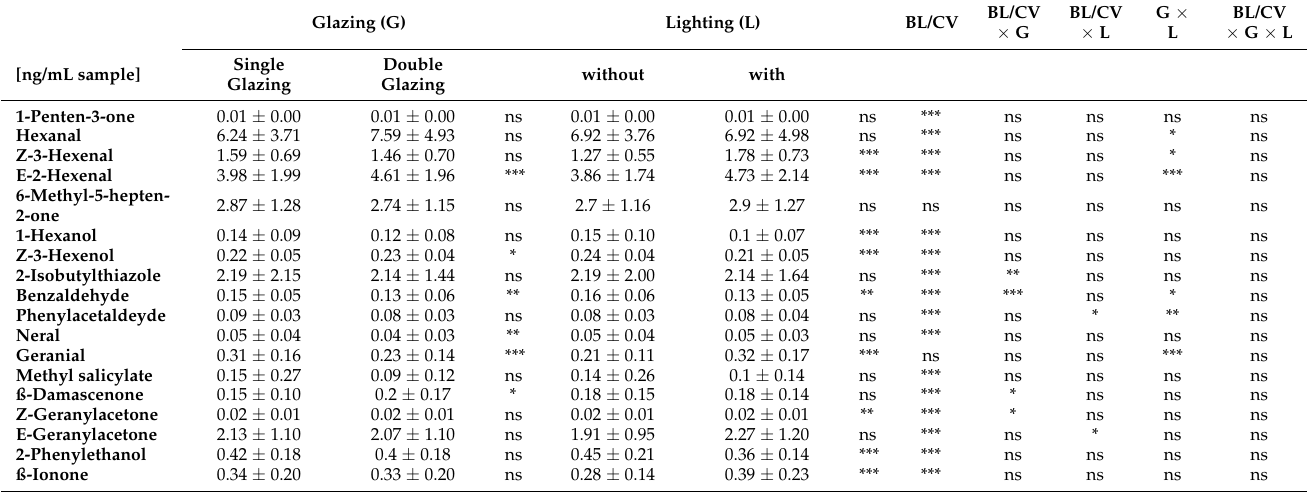
Table 7. Mean values ± standard deviation of 18 aroma compounds of five breeding lines and Lyterno F 1 , distinguished between single-glazed and double-glazed greenhouses or with and without supplementary LED